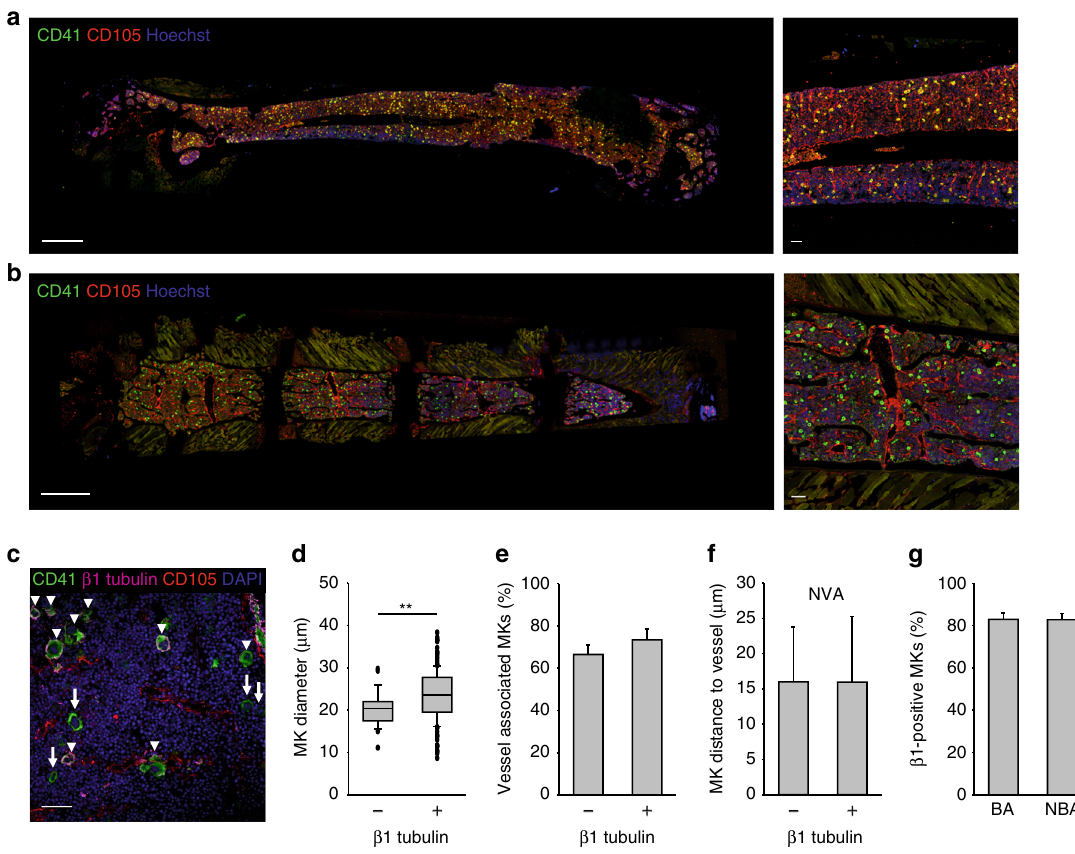
Fig. 2 MKs are largely sessile and distributed within the BM. Distribution of megakaryocytes (MKs, CD41 + , green ) in cryo-sections of femur a and sternum b showing vessels (CD105 + , red ) and nuclei (Hoechst33258, blue , Scale bar: 1 mm ( left panels ), 100 µ m ( right panels ). c MKs were counter-stained for β 1-tubulin ( magenta , indicated with arrowheads — in contrast to β 1 − MKs which are indicated with arrows ); scale bar 20 µ m. These mature MKs were larger d , but distributed similarly as depicted by the percentage of vessel-associated MKs e and the distance to vessels of non-vessel associated (NVA) MKs f . g The percentage of β 1-tubulin positive CD41-cells within 100 µ m distance from the bone cortex (BA bone-associated) and more distant MKs (NBA non-bone associated) was similar. Bar graphs represent mean ± SD; n = 4. ** p < 0.01. There are no signi fi cant differences in e – g ( p >